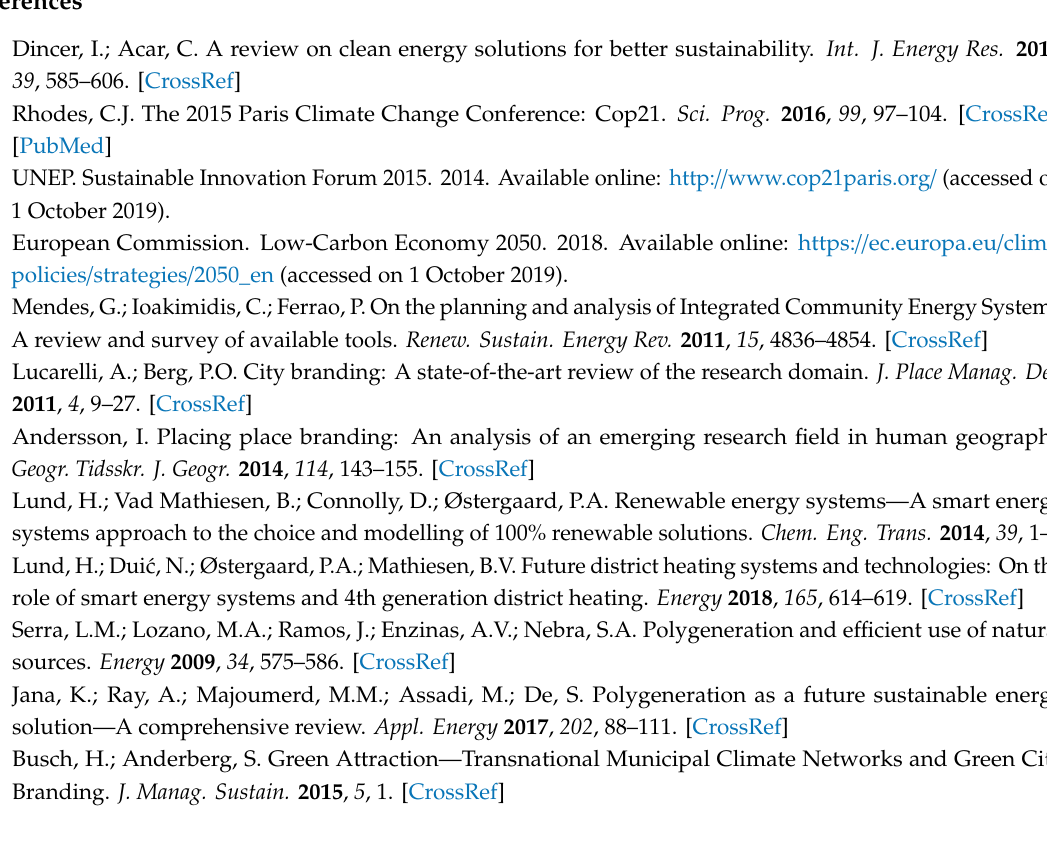
Table A9. Main results of the environmental analysis (on a yearly basis). Case Saved PE (GWh) Avoided CO 2 Emissions (t) stop time of the DHCN at 22:00 27.17 5494 stop time of the DHCN at